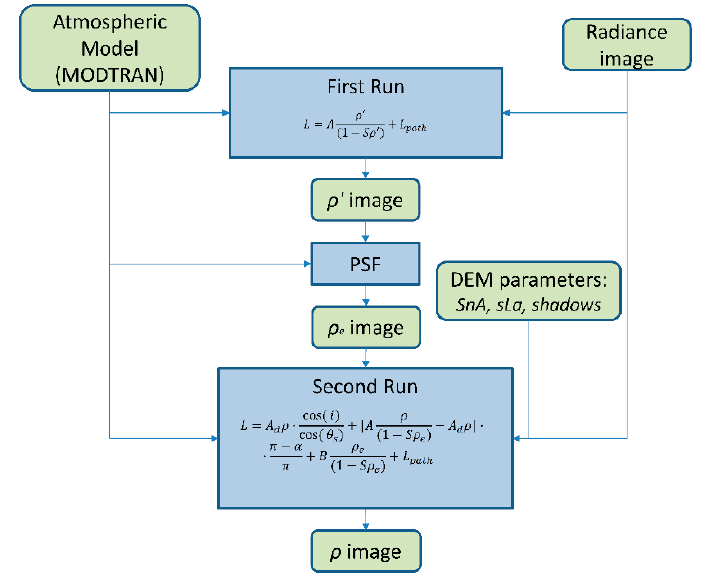
Figure 2. Algorithm flow.